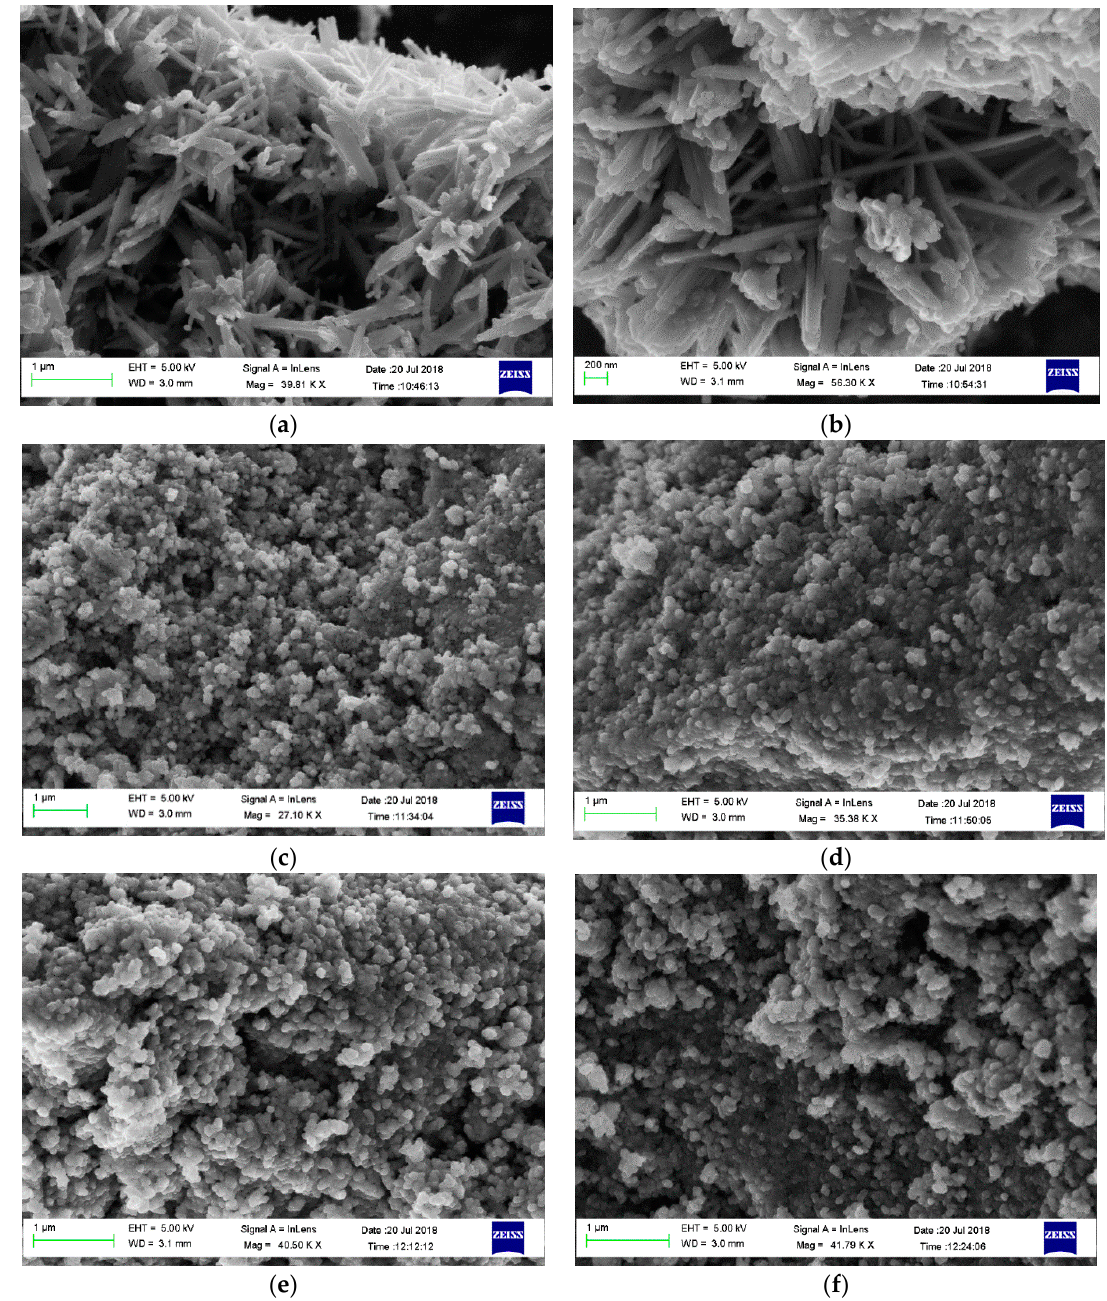
Figure 3. Scanning electron microscopy (SEM) images for ( a ) NiCo 2 O 4 / Co-CX, ( b ) NiCo 2 O 4 / Ni-CX, ( c ) NiFe 2 O 4 / Co-CX, ( d ) NiFe 2 O 4 / Ni-CX, ( e ) CoFe 2 O 4 / Co-CX, and ( f ) CoFe 2 O 4 /